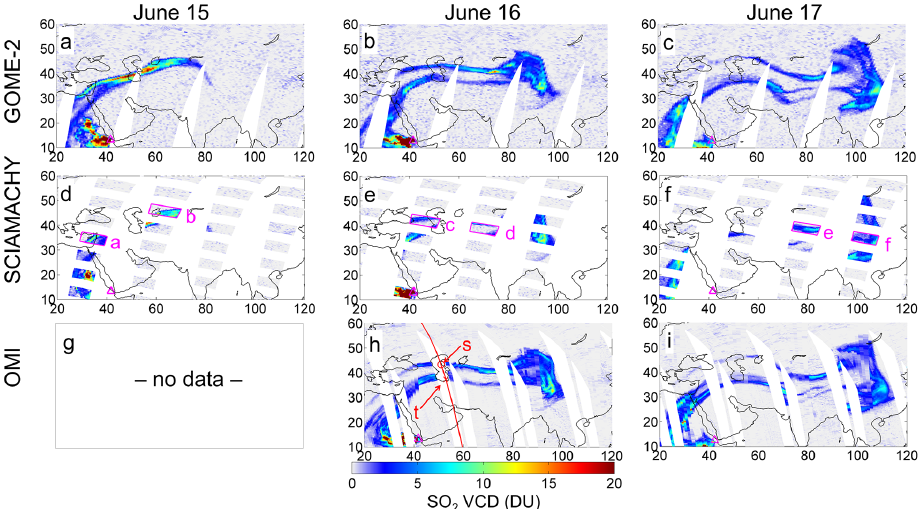
Figure 8. SO 2 time series from GOME-2 (panels a–c in the upper row), SCIAMACHY ( d–f ; centre), and OMI ( g–i ; lower row). Measure- ments from 15 June (left), 16 June (centre) and 17 June 2011 (right) are shown. There are no measurements available from OMI on 15 June. The extinction profiles from the states marked by labelled pink boxes are shown in the corresponding panels of Fig. 9. The red line indicates the ground track of one (near-simultaneous) CALIPSO orbit; the red symbols and arrows mark the locations of tropospheric (“t”, cross) and stratospheric (“s”, circles) aerosol layers detected by